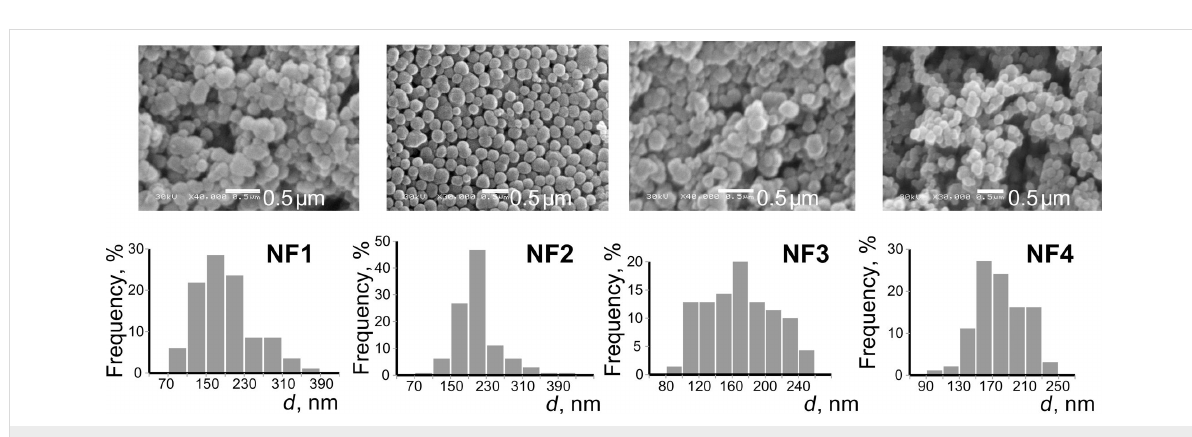
Figure 2: SEM images of amino-/fluorine-containing samples.